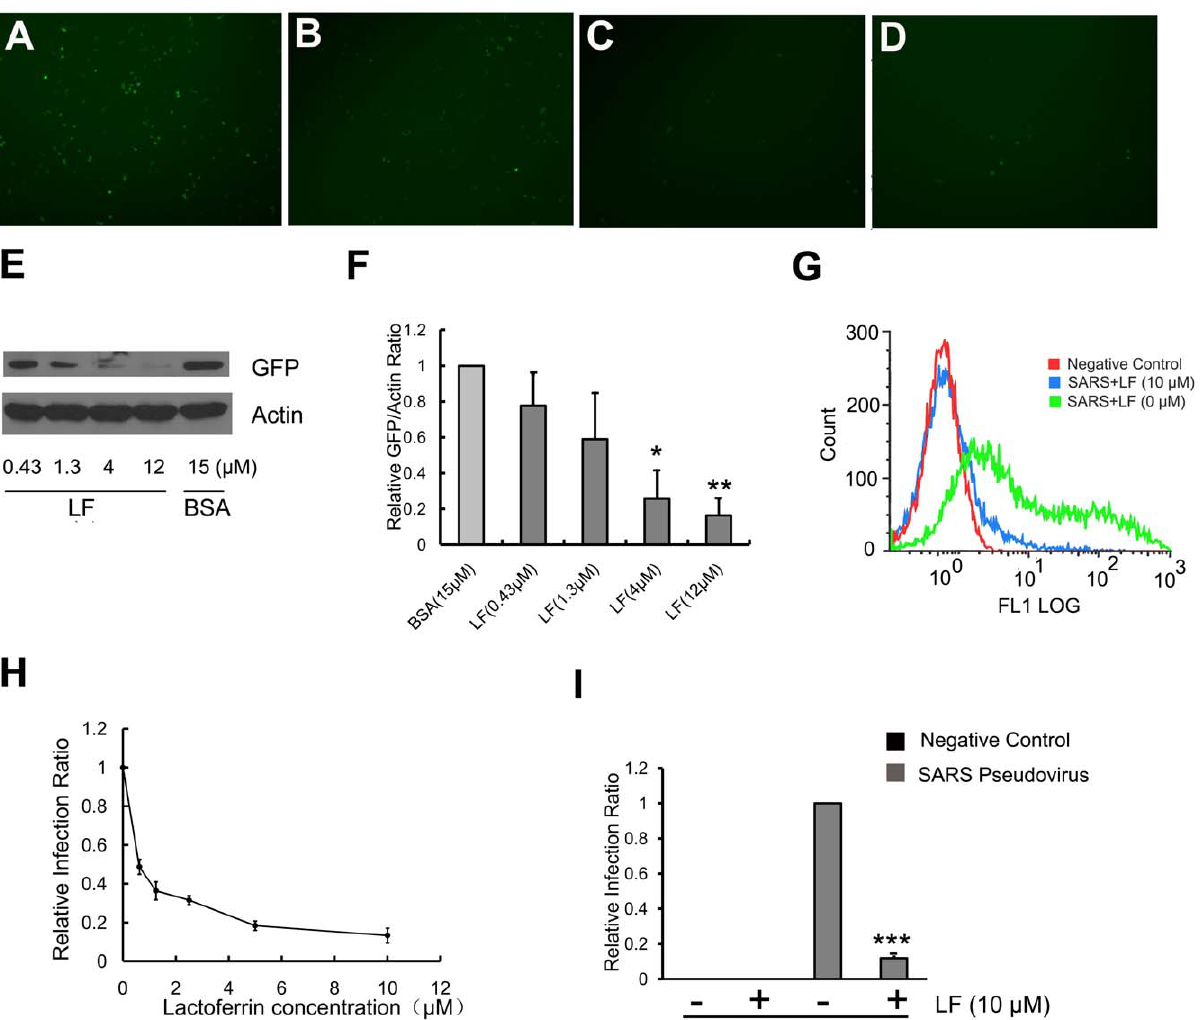
Figure 1. Lactoferrin inhibits SARS pseudovirus infection of HEK293E/ACE2-Myc cells. ( A–D ) Fluorescence microscopy illustrates that the number of SARS pseudovirus-infected GFP-expressing HEK293E/ACE2-Myc cells decreases in the presence of LF. HEK293E/ACE2-Myc cells were treated with LF for 1 h at 37 u C at the concentration of 1 m M (B), 3 m M (C) or 10 m M (D). BSA (10 m M) was used as control (A). The LF-pretreated cells were treated with SARS pseudovirus as described in Methods. ( E and F ) Western blotting reveals that LF markedly reduces GFP expression in HEK293E/ACE2-Myc cells incubated with SARS pseudovirus. Statistical analysis of the relative band density ratio of GFP to actin was performed using a t -test. Error bars represent the SD of three independent experiments. **P , 0.01 and *P , 0.05. ( G and H ) Flow cytometry demonstrates that LF is able to inhibit the infection of HEK293E/ACE2-Myc cells by SARS pseudovirus. The concentration of LF was 0.625 m M, 1.25 m M, 2.5 m M, 5 m M or 10 m M. BSA (10 m M) served as control. The percentage of GFP expressing cells in the total population was calculated by flow cytometry. The relative viral infection ratio was measured by comparing the percentage of GFP expressing cells in each group with that of the BSA control. Error bars represent the SD of three independent experiments. ( I ) No GFP expression can be detected in the cells treated with viral particles without spike protein. The percentage of GFP expressing cells in the total population was calculated by flow cytometry as described above. Error bars represent the SD of three independent